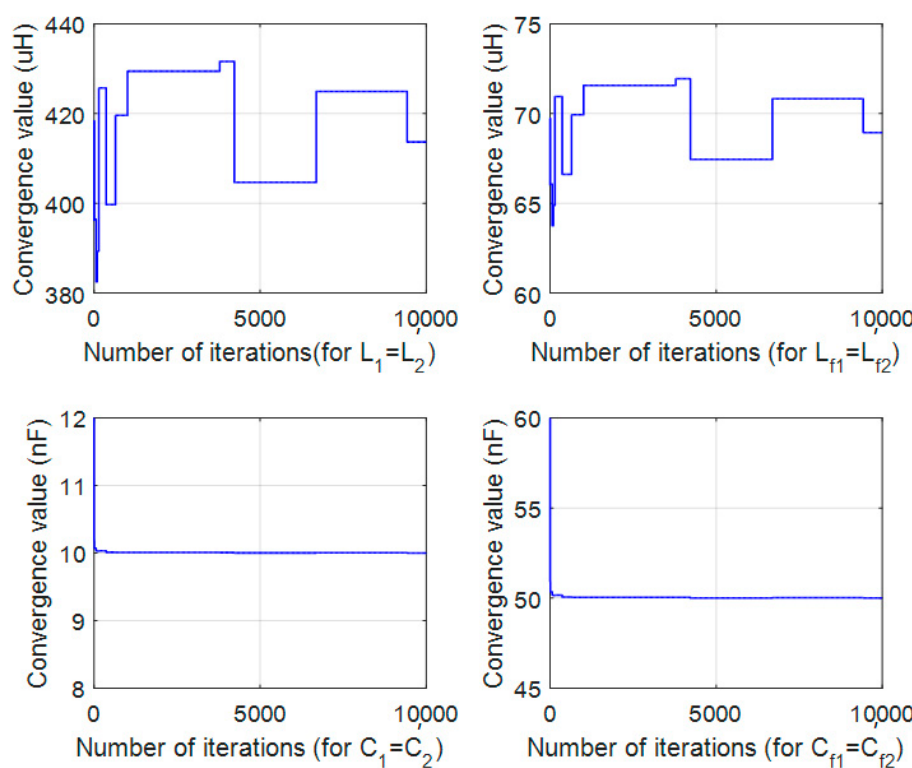
(cid:16) (cid:17) ( Figure 2. Sample paths for L 1 , L 2 , L f 1 , L f 2 , C 1 , C 2 , C f 1 , C f 2 . Figure 2. Sample paths for Misalignment in static WPT can be applied to simulate the approaching or leaving sta- tuses (or both) of dynamic WPT. In dynamic WPT, parameter drift affects the